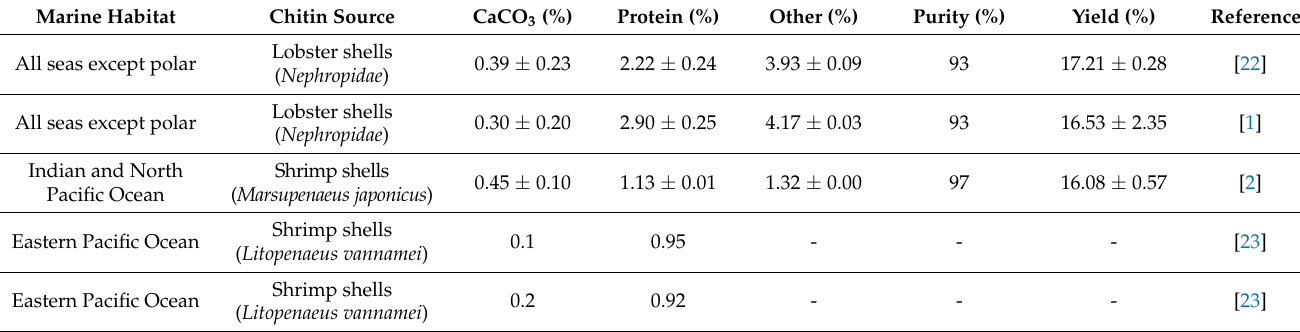
Table 1. The purity, yield, and constituents of chitin extracted using the chemical method. Species habitat was identified through searches of the Global Biodiversity Information [17], the Food and Agriculture Organisation of the United Nations Fact sheets [18–20] and the Marine Life Information Network